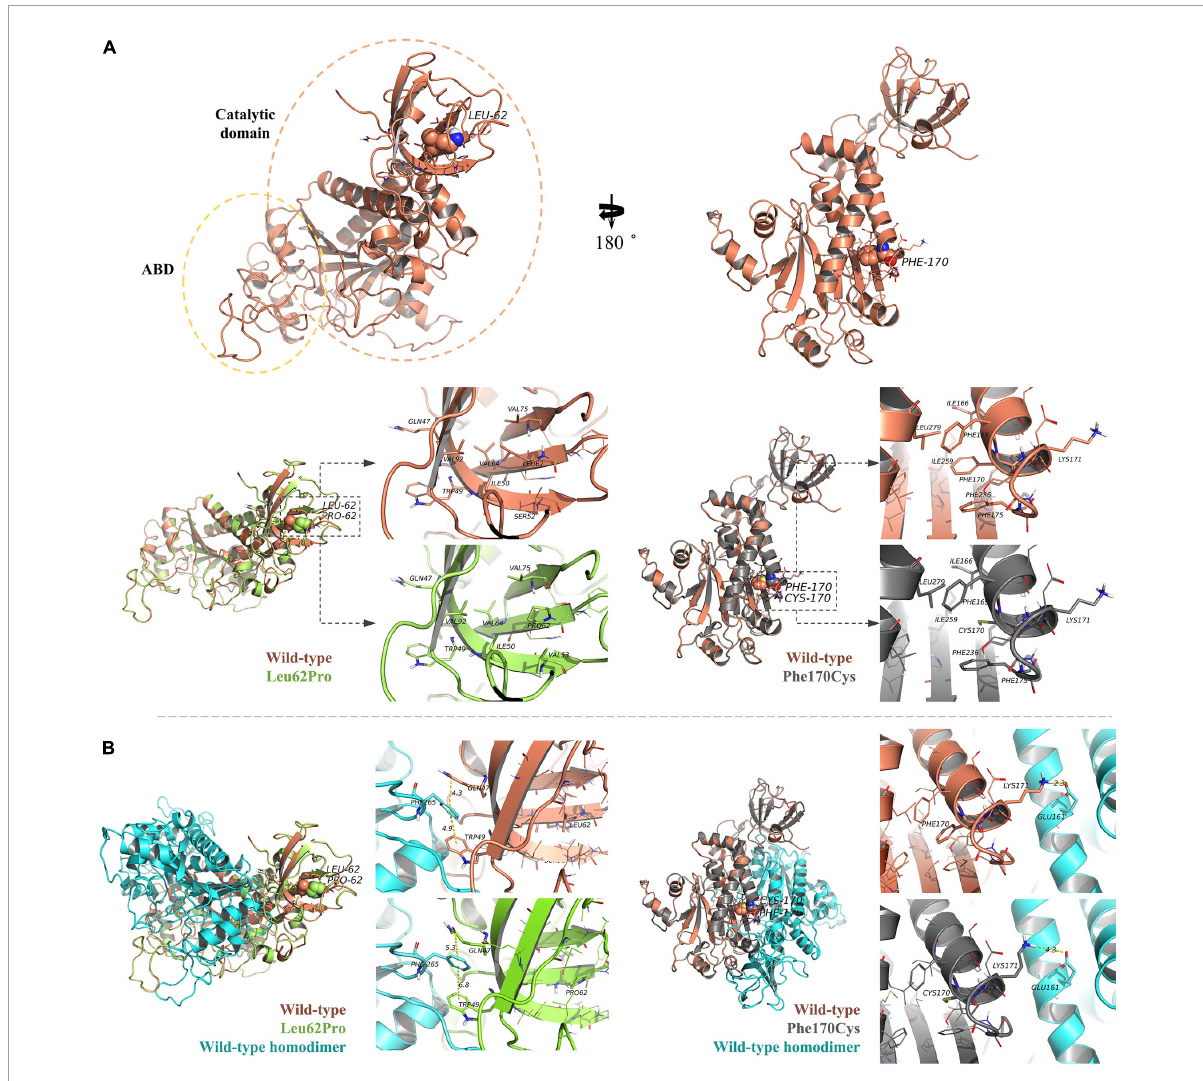
FIGURE4 Protein structure prediction analysis. (A) The human NARS2 protein is composed of anticodon-binding and catalytic domains and functions as a homodimer. Wild-type Leu62 (in brown) is located in a pocket, surrounded by a hydrophobic group in the deep part of the protein, and forms a hydrophobic interaction with surrounding residues. Mutant Leu62Pro (green) may weaken the hydrophobic interaction with Val92. Another mutant Phe170Cys ( black) is located in the pocket structure surrounded by hydrophobic groups, possibly weakening the interaction between Lys171 and Glu161 in the homodimer. (B) Molecular dynamics simulations predict that the mutation is affected the stability of the dimer structure. In the wild-type homodimers, Gln47 and Trp49 have formed stable interactions with the dimer Phe265, with distances of 4.3 and 4.9 angstroms (Å), respectively, while mutant Leu62Pro has weakened the interaction force, with distances of 5.3 and 6.8 Å, respectively. In the wild-type homodimer, Lys171 forms a hydrogen bond with the dimer Glu161, with a distance of 2.3 Å. In mutant Phe170Cys, the distance is 4.3